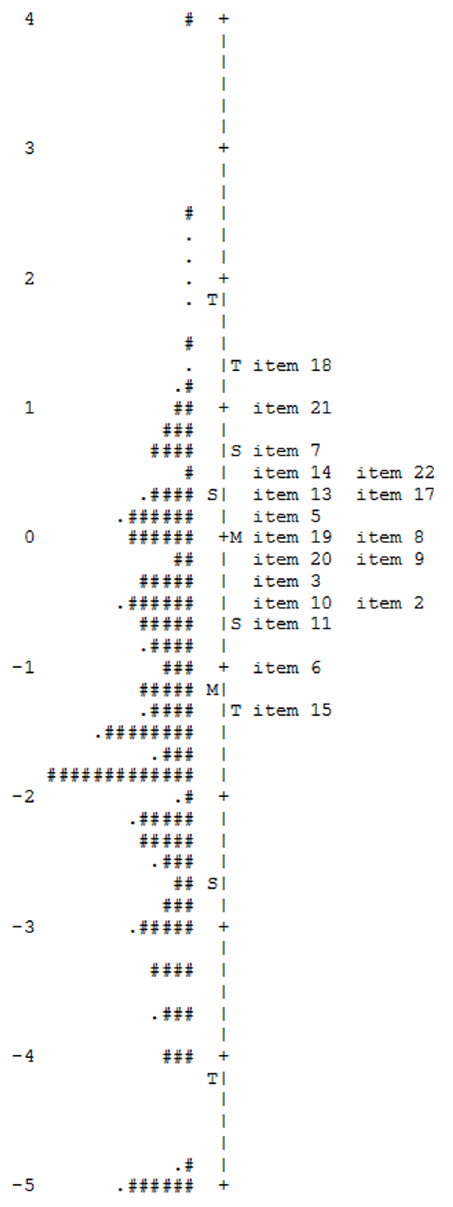
Figure 5. Person-item map (Each '#' represents two